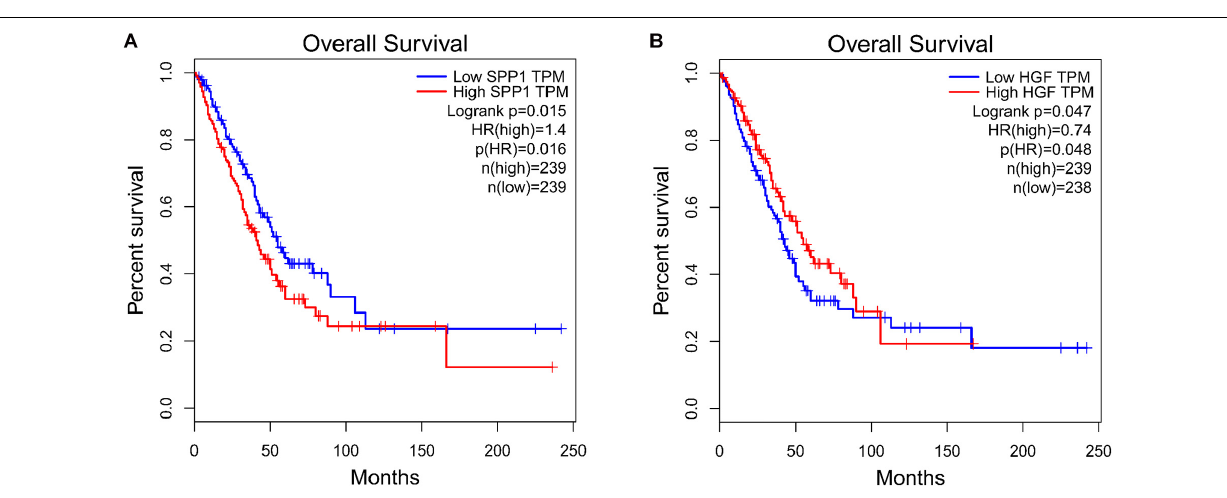
FIGURE 7 | Survival analysis for the hub genes. (A) SPP1, secreted phosphoprotein 1 and (B) HGF, hepatocyte growth factor. TPF, transcripts per kilobase of exon model per million mapped reads; HR, hazard